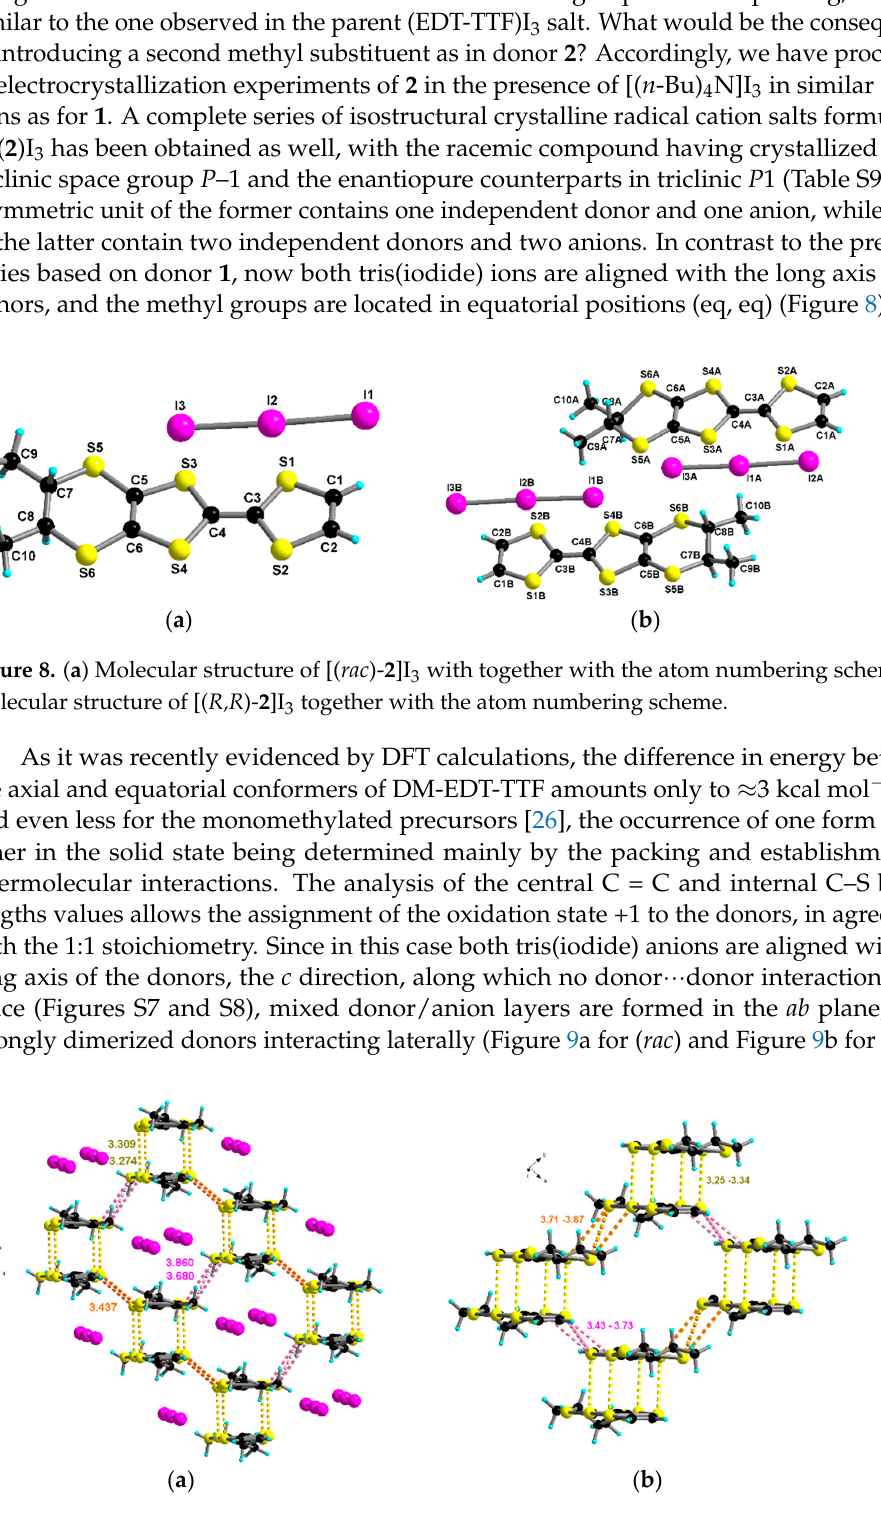
Figure 7. Packing of donors in the structure of [( R )- 1 ]I 3 with emphasis on the S···S contacts shorter than 3.6 Å: red dotted lines for 3.33, 3.35 and 3.39 Å; green dotted lines for 3.45 and 3.48 Å. Although the interdimer S···S distances for these lateral donor···donor contacts are as short as 3.45–3.48 Å (Figure 7), one can expect very weak conductivity for these radical cation salts of 1:1 composition when considering the strong dimerization of the donors.